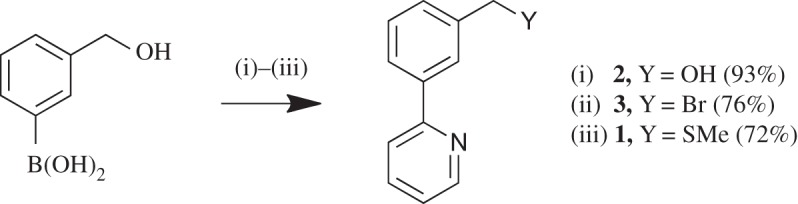
New synthesis of SCN ligand 1. (i) 2-Bromopyridine, Pd(PPh3)4, base/solvent. (ii) HBr. (iii) NaSMe, EtOH.